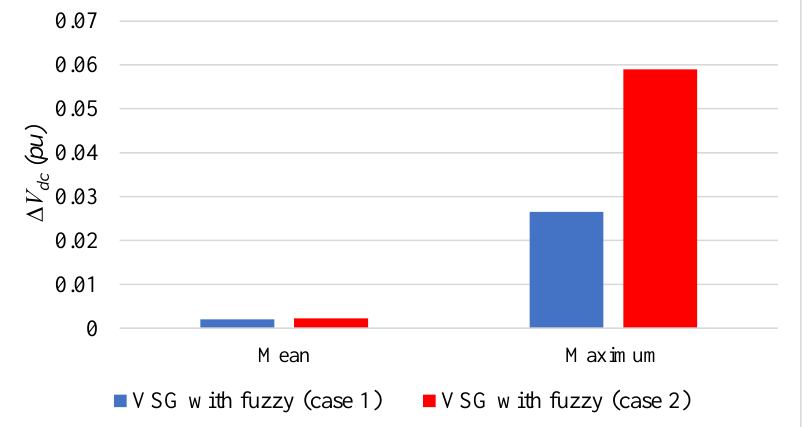
Figure 32. DC-link voltages statistics of DER 1 for the different scenarios presented in Section